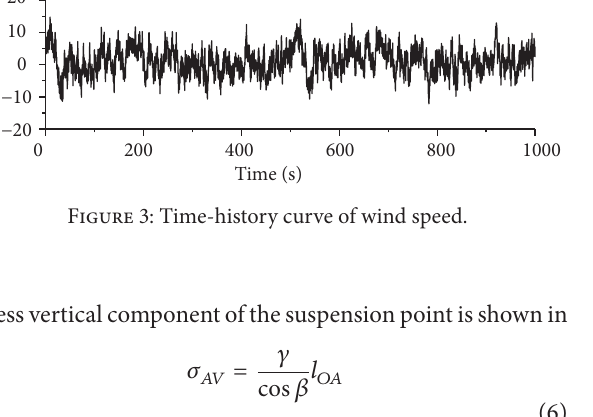
Stress vertical component of the suspension point is shown in